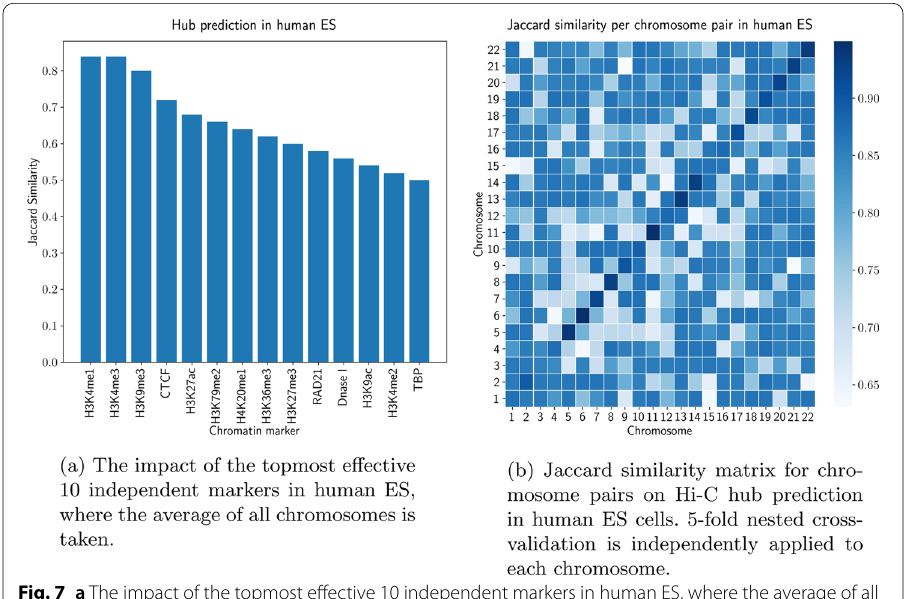
Fig. 7 a The impact of the topmost effective 10 independent markers in human ES, where the average of all chromosomes is taken. b Jaccard similarity matrix for chromosome pairs on Hi–C hub prediction in human ES cells. Fivefold nested cross-validation is independently applied to each